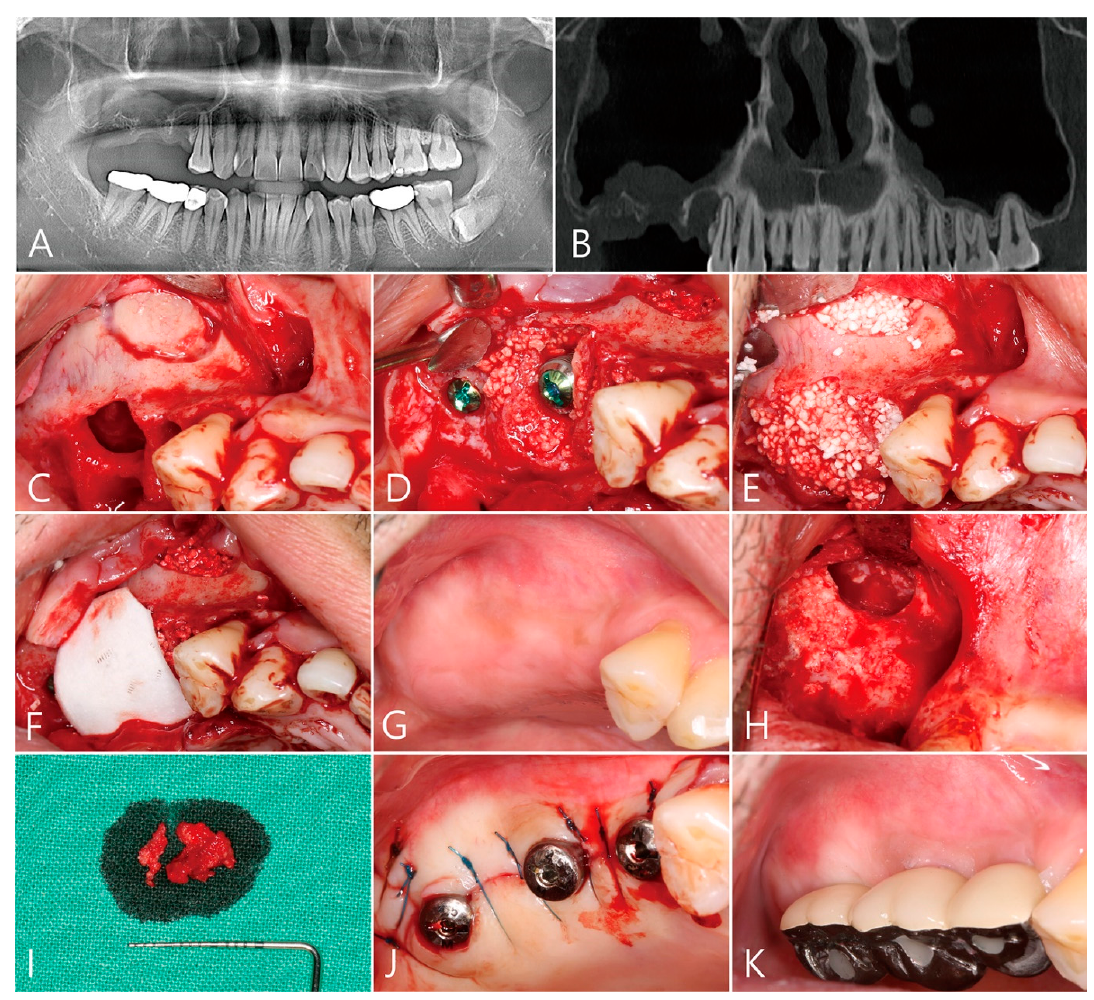
Figure 1. Case 1. ( A ) Preoperative panoramic radiography. A severe defect is present in the maxillary right posterior extraction socket, and the height of the residual bone is low; ( B ) panoramic image of CBCT taken preoperatively. A compromised extraction socket is observed in the right maxillary sinus, and the maxillary sinus membrane is thickened; ( C ) after the flap was reflected, the granulation tissue in the extraction socket was thoroughly removed. The buccal bone defect was severe. A lateral bone window was prepared for sinus floor elevation; ( D ) the maxillary sinus bone graft using synthetic bone graft substitute was performed and two implants were installed; ( E ) the peri-implant defect was additionally filled with a bone graft substitute; ( F ) resorbable collagen membrane was used to cover the grafting material and the flap was closed; ( G ) clinical findings 6 months after surgery. Healing was uneventful; ( H ) After the flap was reflected, the graft void was removed; ( I ) the removed specimen which was not clearly separated from the surrounding tissue; ( J ) after insertion of the healing abutment, the flap was closed; ( K ) Clinical appearance after delivery of the